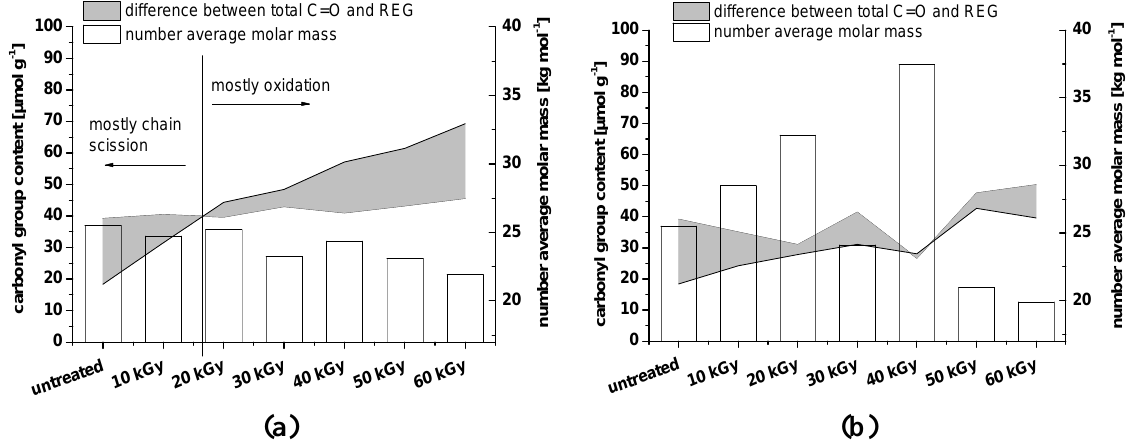
Figure 9. Content of REG compared to the total amount of carbonyl groups (determined by fluorescence labeling). The shaded area corresponds to the difference between total C=O and REG, representing oxidation on the cellulose backbone (when the shaded area expands below the black line). As the calculation of REG is based on the number average ), the data are shown as well (empty bars). ( a ) MFC wet; ( b ) MFC dry. The molar mass ( M n untreated material is identical in the two